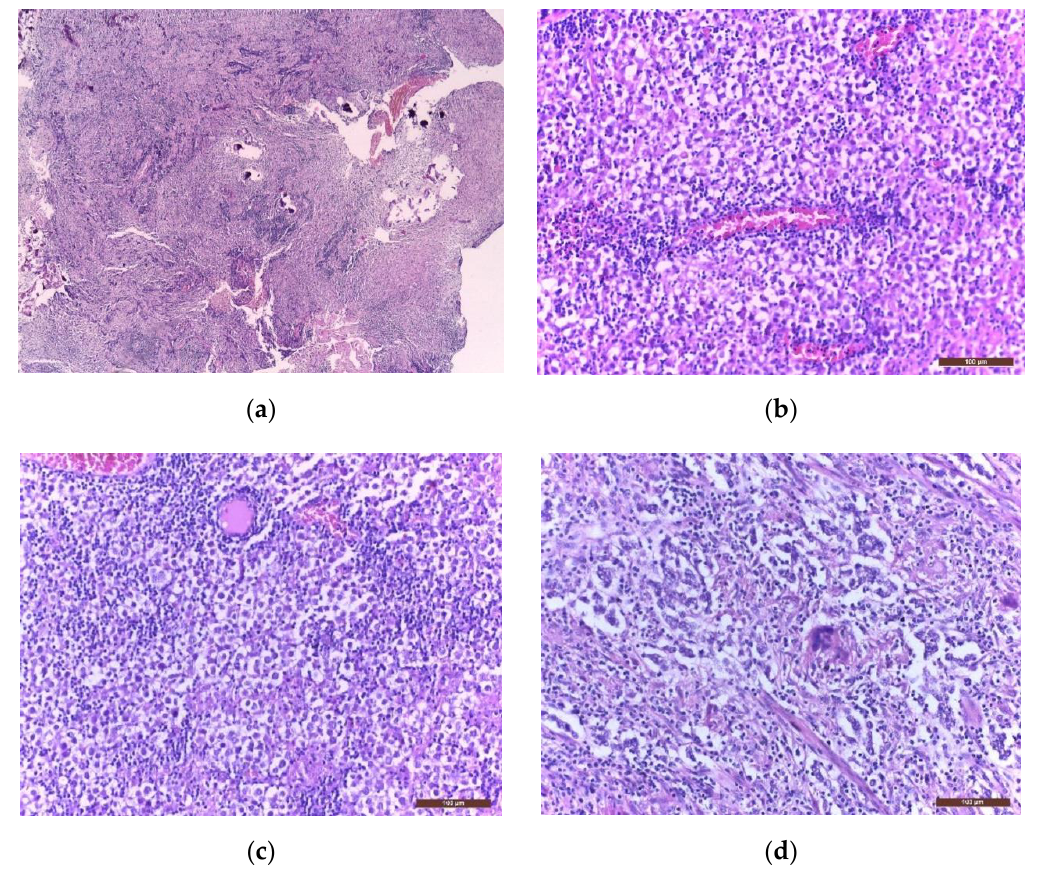
Figure 3. Microscopic images of extragonadal germinomas are identical with those of their gonadal counterpart: ( a ) pineal gland, with multiple small basophil psammoma bodies, infiltrated by a germinoma; ( b ) tumour proliferation with fine vascular network; ( c ) sheets of large germinoma cells, with pale cytoplasm, well defined cell membranes, large round central nuclei, and fibrous septae heavily infiltrated by lymphocytes; ( d ) an isolated multinucleated syncytiotrophoblast close to the centre of the image; (hematoxylin eosin staining; ( a ) 40× and ( b – d ) 200×).